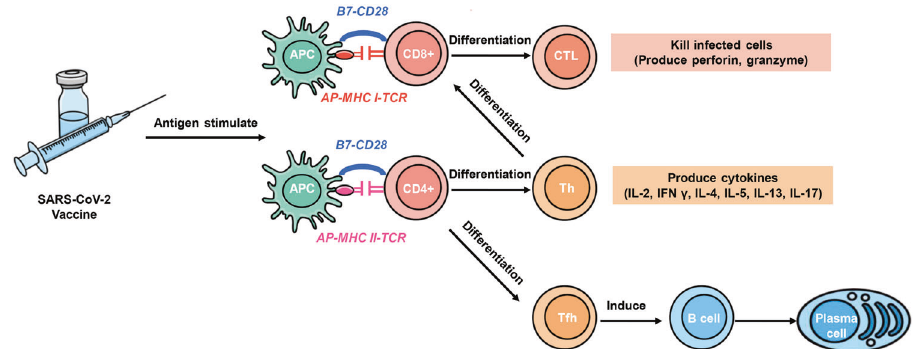
Fig. 2 Vaccine-induced Th1 cell response. Some COVID-19 vaccines would induce Th1 cell responses. After recognition of the AP-MHC class II complex and T-cell receptor (TCR), CD4 + T cells distributed in peripheral lymphoid organs can differentiate into Th1 cells, which secrete various cytokines, such as interleukin 2 (IL-2), and simultaneously upregulate the expression of related receptors (IL-2R). Through IL-2 and IL- 2R, T-cell proliferation and CD8 + T-cell activation are promoted, CD8 + T-cell can differentiate into cytotoxic T lymphocytes (CTLs) through the activation, producing perforin and other cytokines, which may improve the ef fi cacy of vaccines